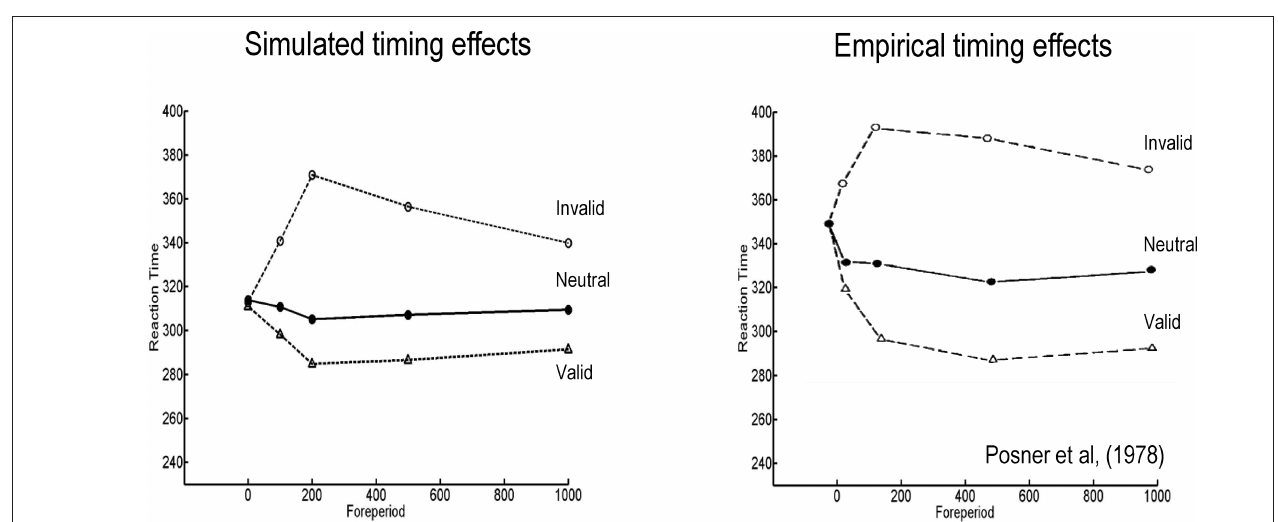
Figure 4 | Left panel: the posterior probability of a target being present as a function of peristimulus time, which can be interpreted in terms of a speed-accuracy trade-off. A reaction time can be derived from this data, as the post-stimulus time taken to achieve a fixed level of accuracy, as determined by the posterior or conditional confidence. In this example, 80% conditional confidence is attained at about 340 ms for valid targets (solid line). However, for